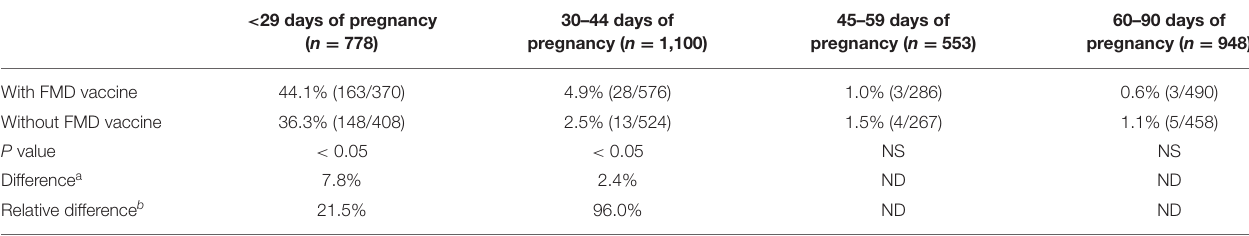
TABLE 2 | Pregnancy failure in beef cows after receiving a vaccination against foot-and-mouth disease (FMD) at different gestational ages.